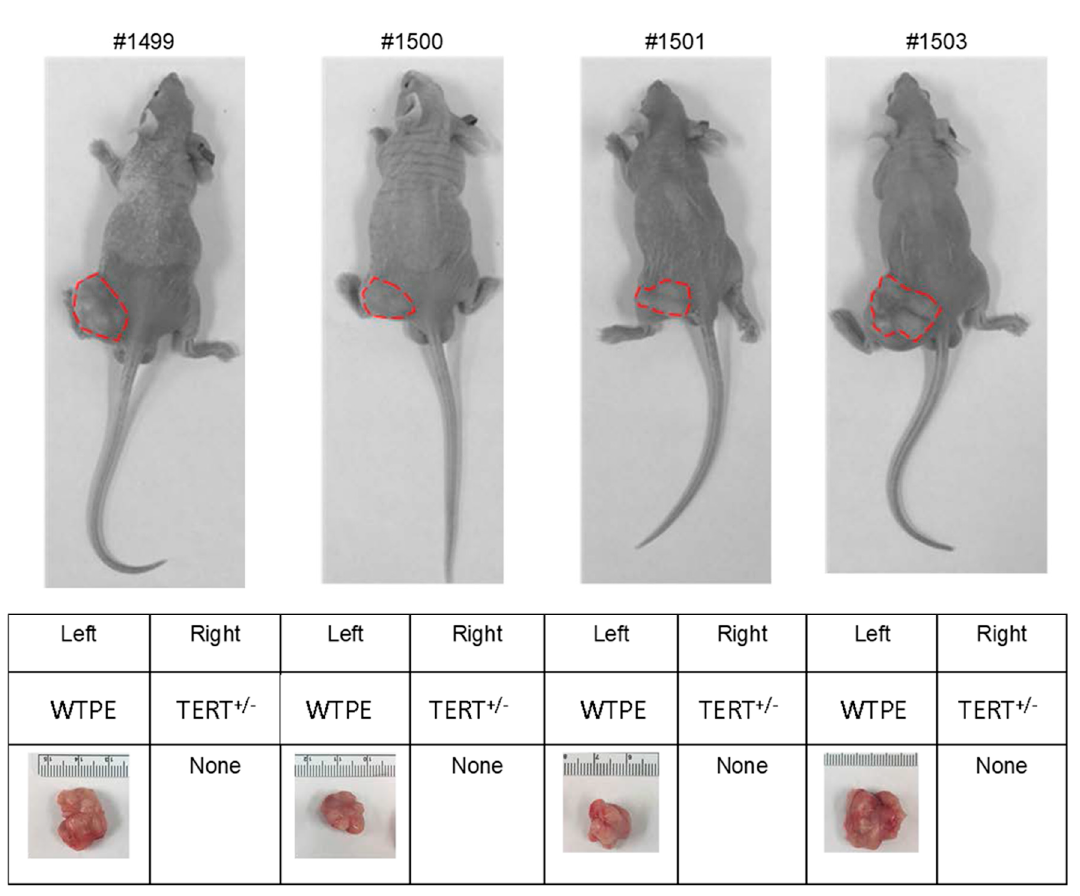
Figure 4. Xenotransplant of WT and TERT +/ − Hela cells in nude mice. Top: nude mice received TERT +/ − Hela cells on their right hind legs, and WT Hela cells on their left hind legs. Red circle: visible xenotransplant mass. Bottom: Summary table of xenotransplant results.